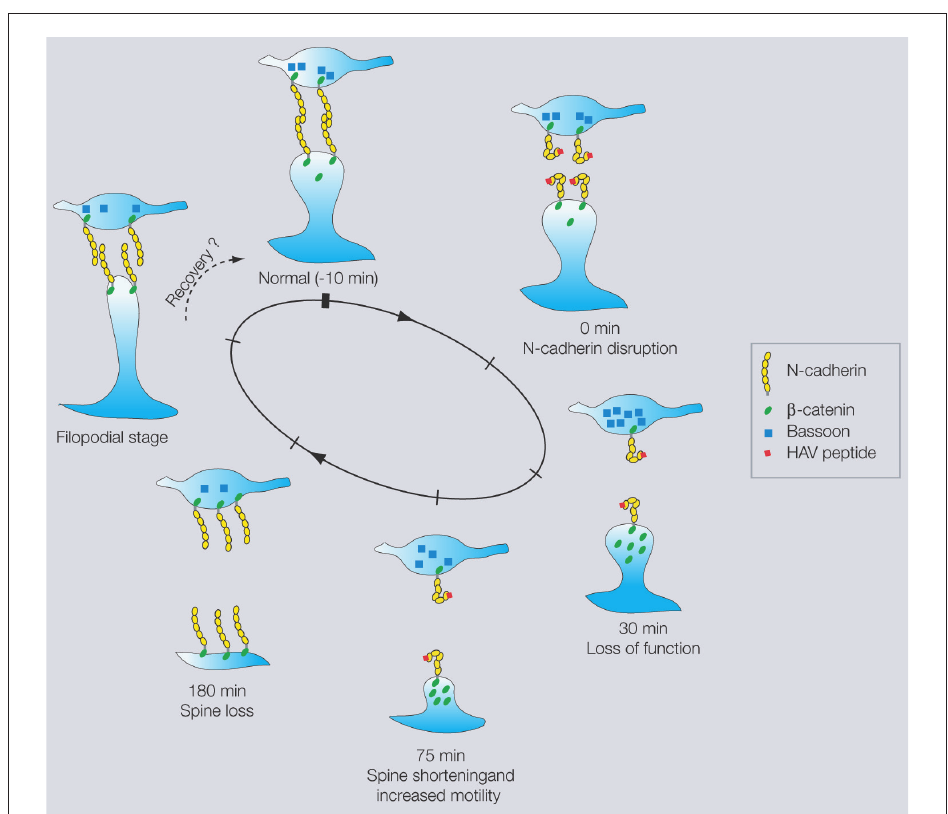
Figure 4 | Working model of effects of N-cadherin disruption showing in each case, a presynaptic terminal and a postsynaptic